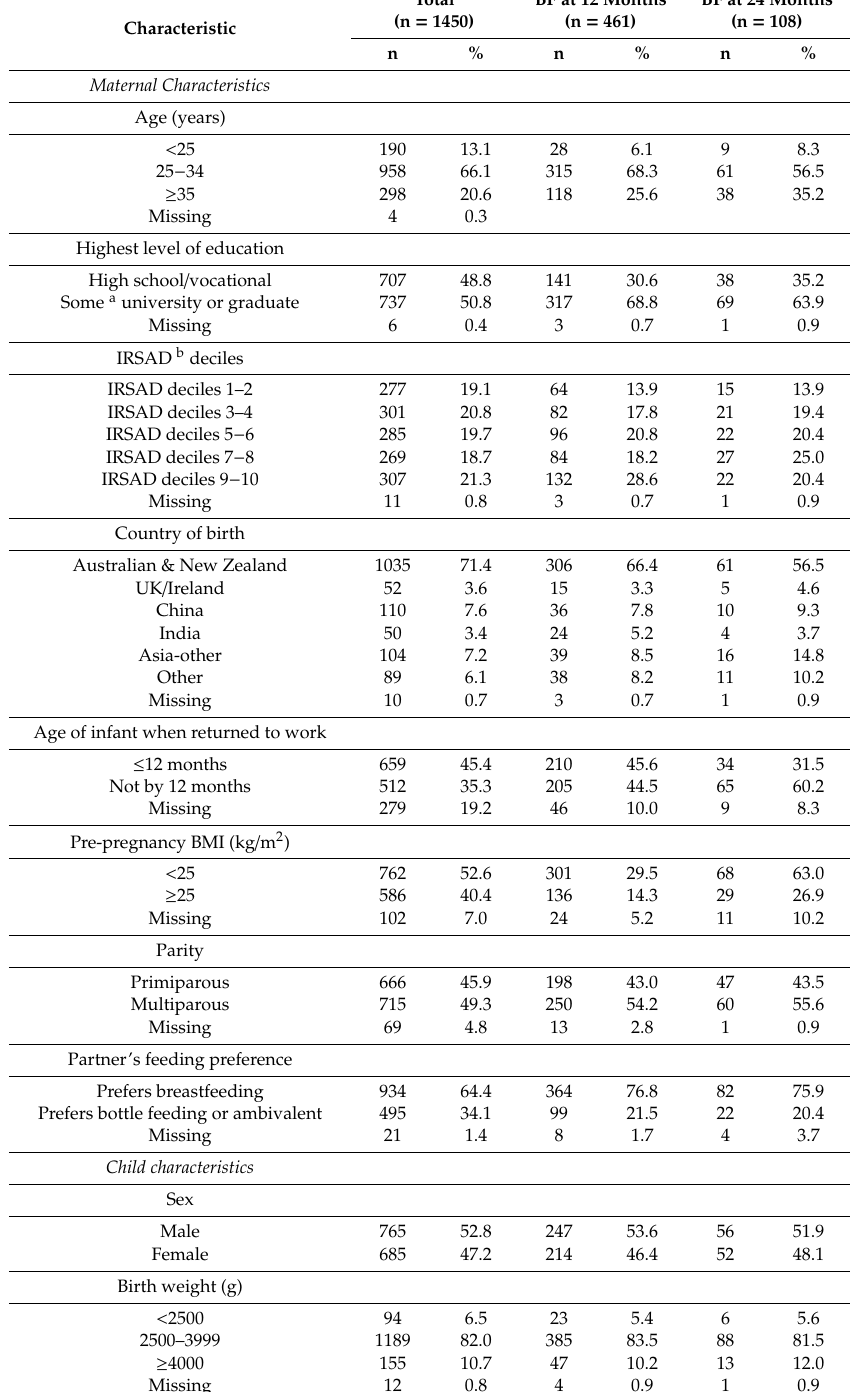
Table 1. Characteristics of SMILE participant mothers and children with known breastfeeding duration up to 24